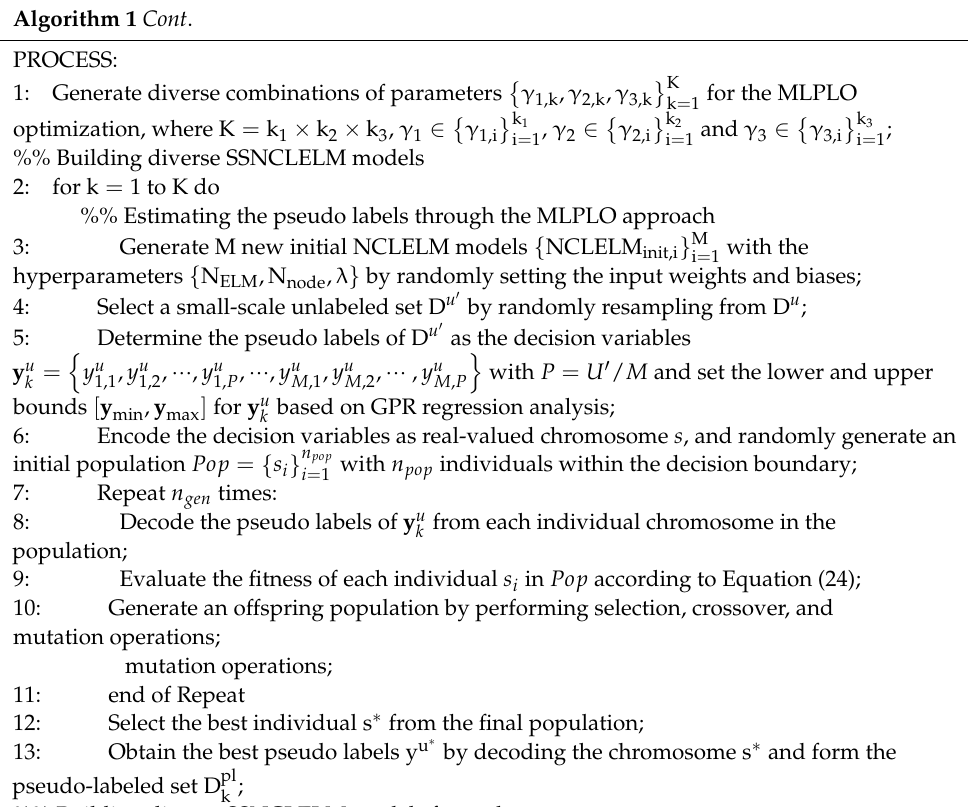
Algorithm 1 Cont